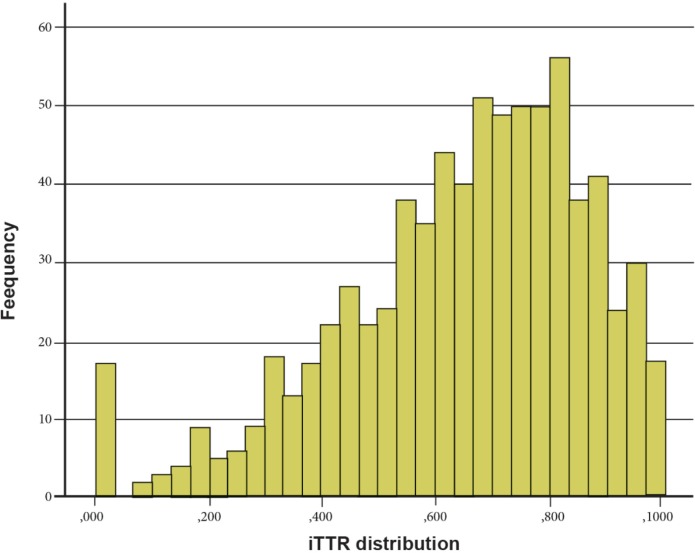
iTTR distribution.